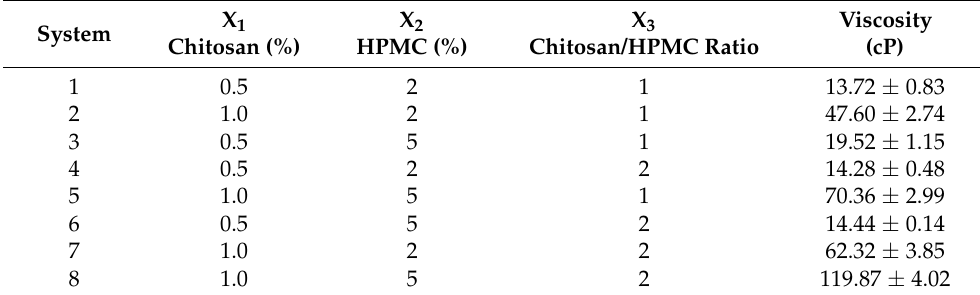
Table 6. The results obtained after determining the viscosity parameter for the analyzed col- loidal